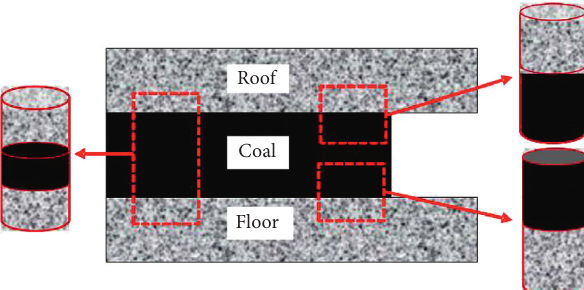
Figure 6: Theoretical model of coal-rock composite samples.